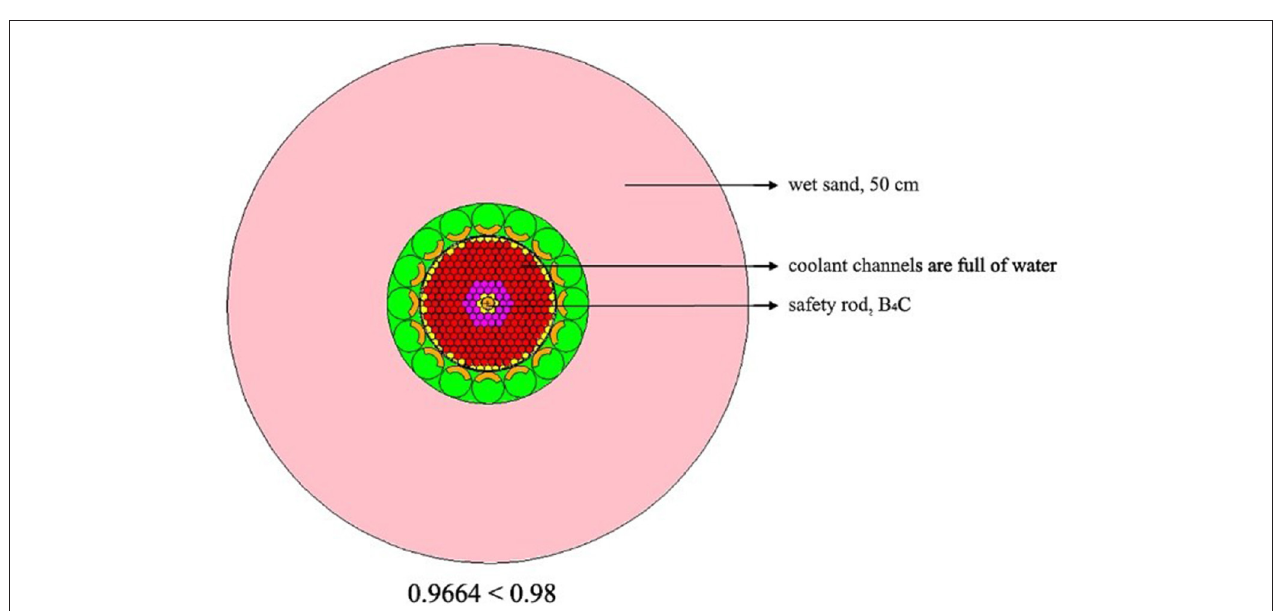
FIGURE 8 | Calculation result of reentry accident in wet